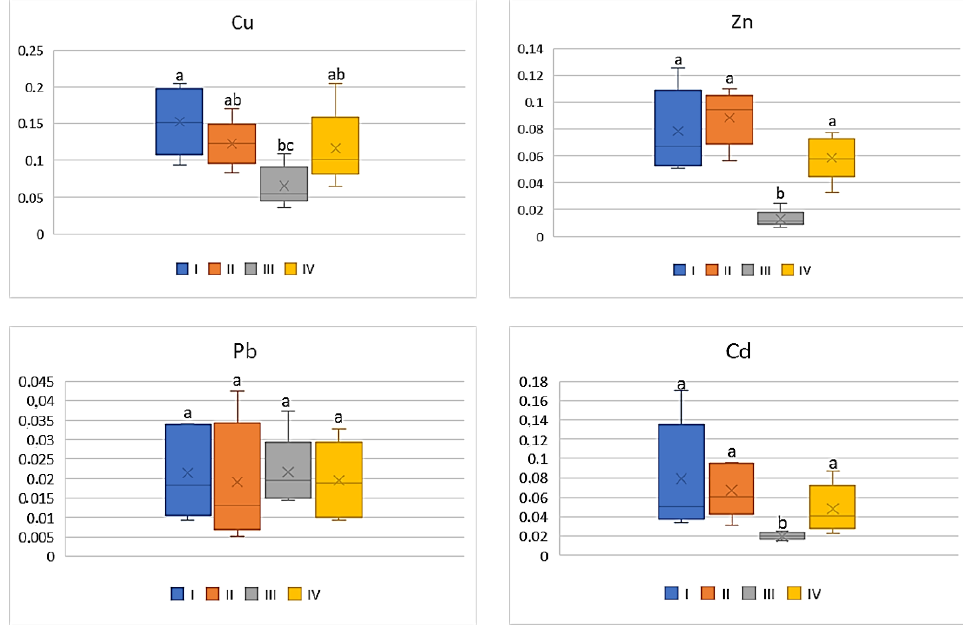
Figure 2. BCF values for carrots depending on the metal and study zones. The same letters mean no significant differences between the values.